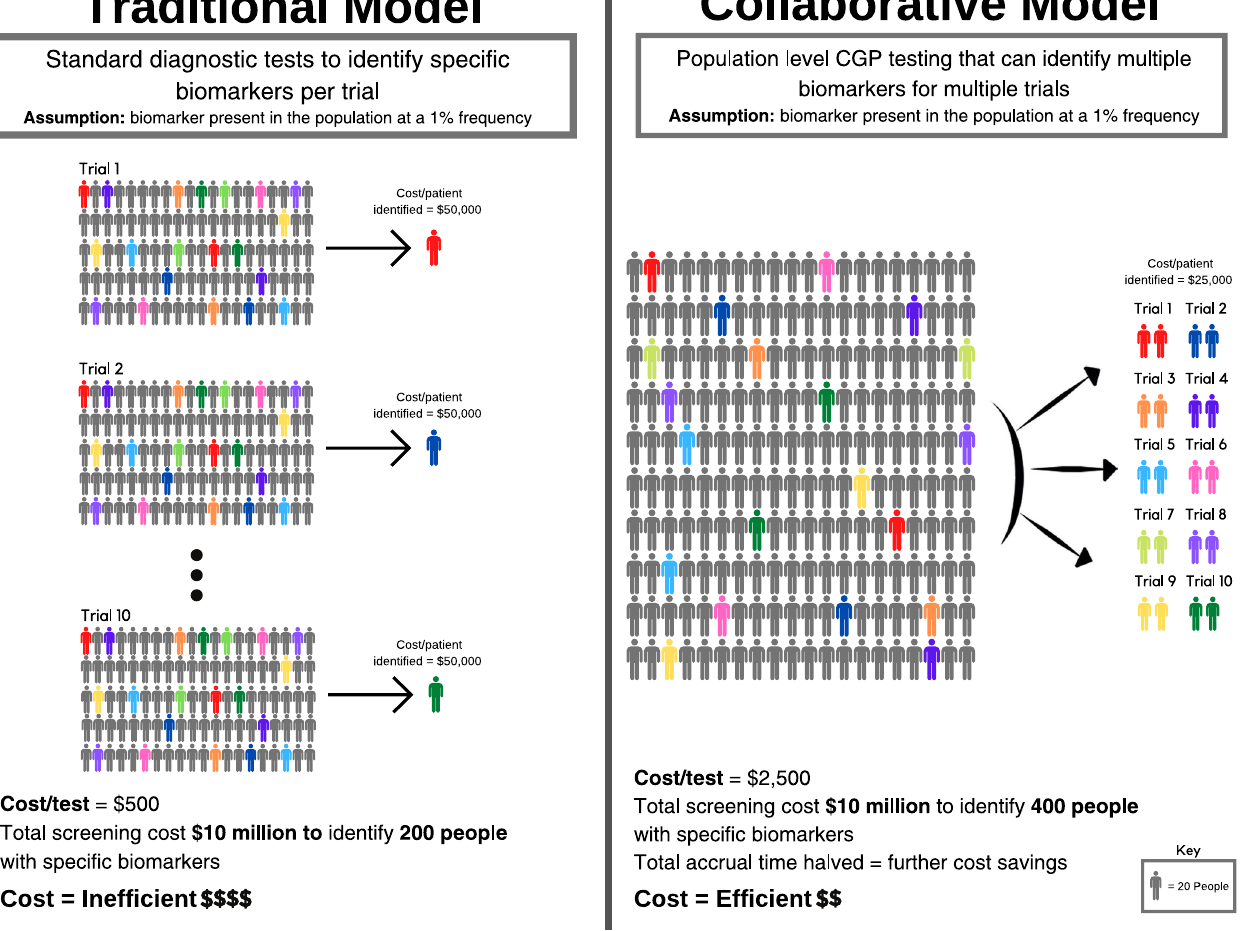
Fig. 3 Ef fi cient identi fi cation of eligible patients for biomarker-dependent drug trials by population screening. ©[Pixeden] via